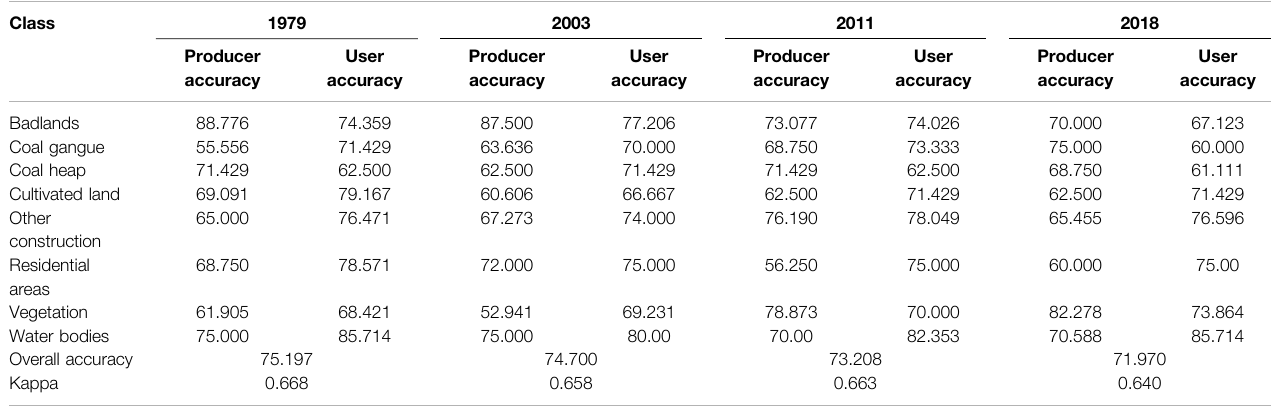
TABLE 3 | Accuracy assessment for the random forest classi fi cation results from 1979 to 2018 (unit: %). Class